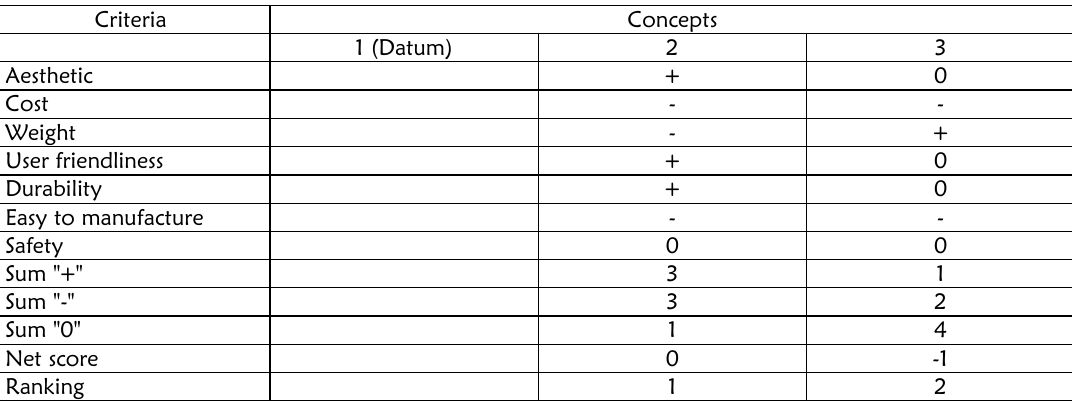
Table 5: Evaluation matrix for concept